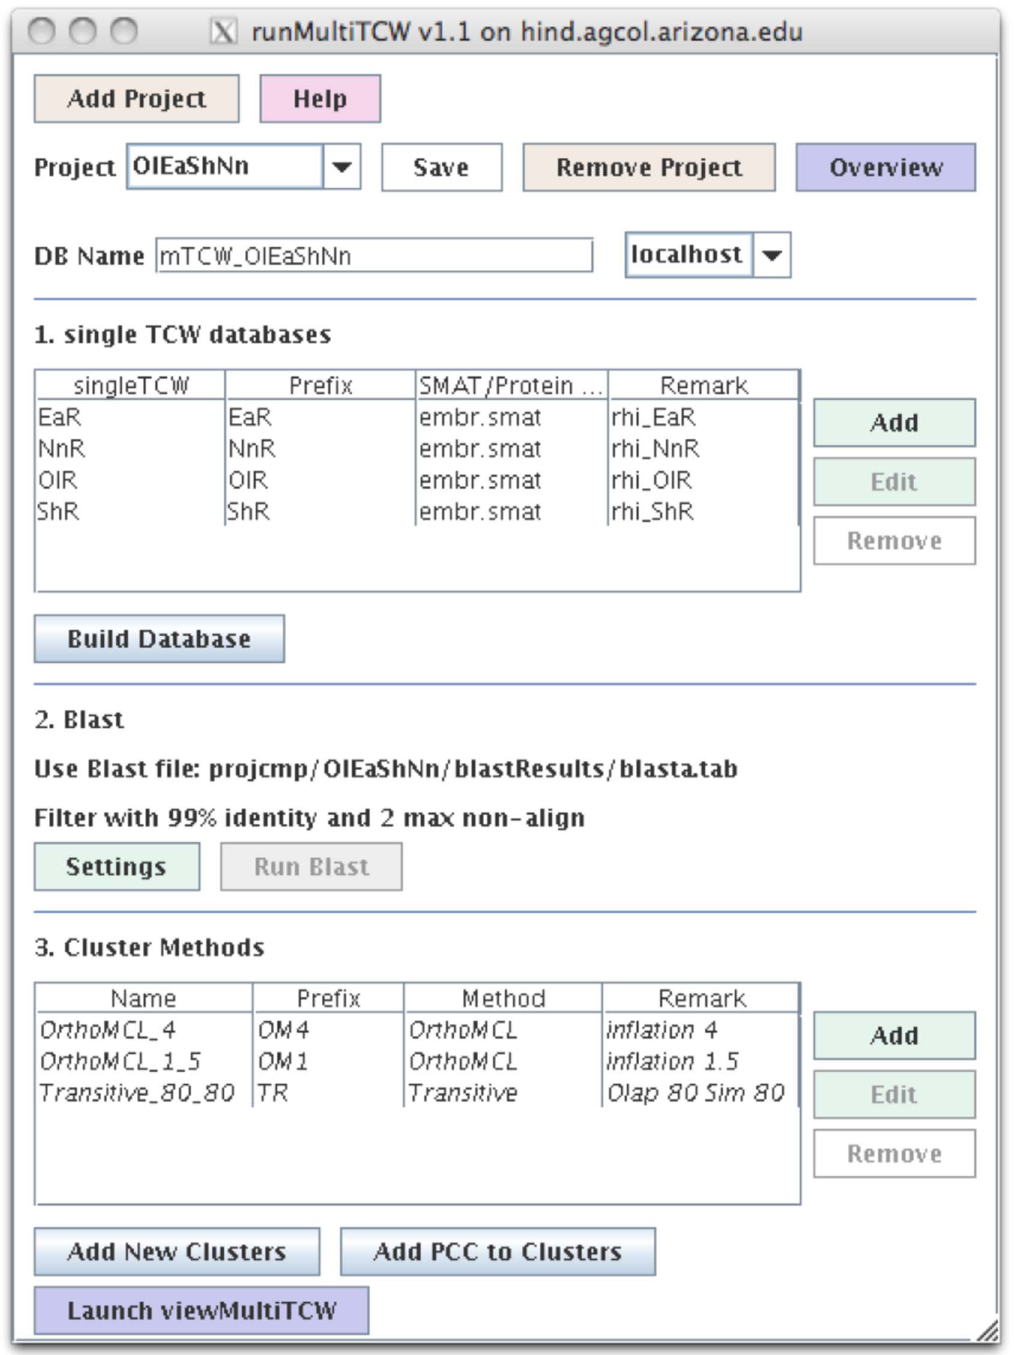
Figure 4. The runMultiTCW interface. This shows the configuration for building a comparison multiTCW database of 4 rhizome singleTCW databases. Three cluster methods were performed: orthoMCL with inflation 1.5, orthoMCL with inflation 4, and transitive with 80% similarity and 80% overlap. The italicized methods indicate they have been added to the database; new clusters can be added and will not be italicized until processed.